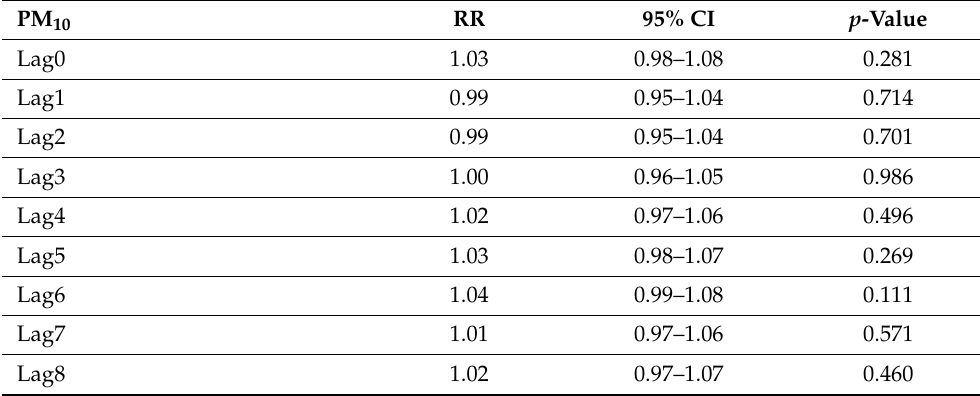
Table 3. The associations between the daily concentration of PM 10 and the daily fatal AMI with different lags (adjusted RR per IQR